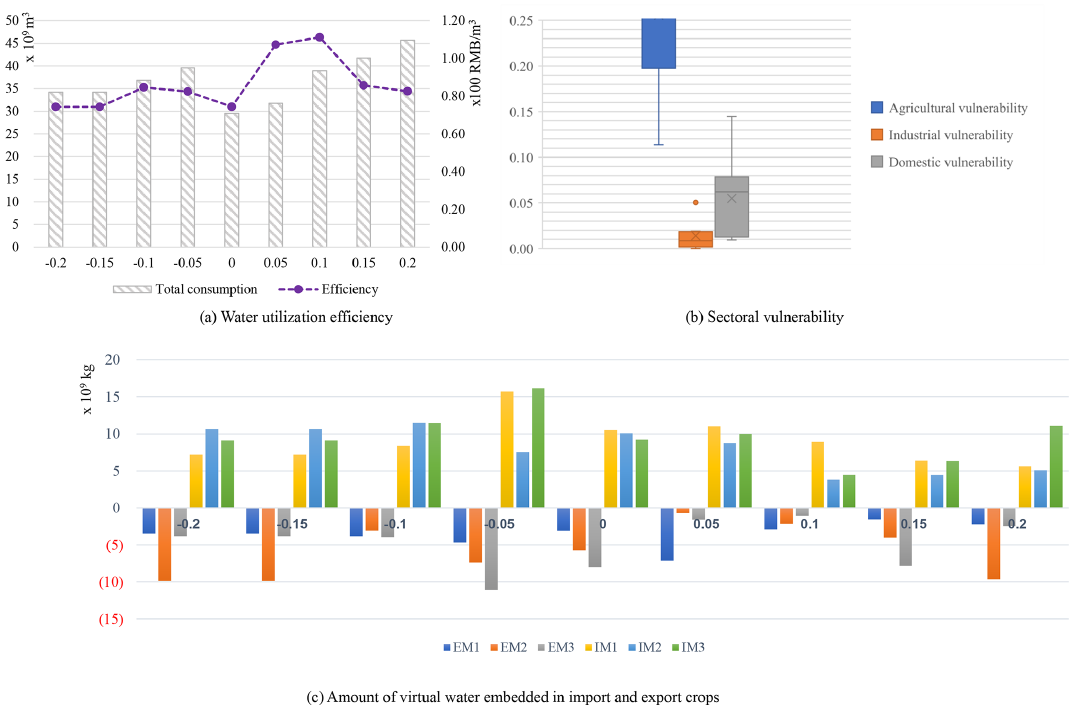
Figure 8. Sensitivity analysis of available water (in Fig. 8c virtual water embedded in export crops is shown below the x axis, while virtual water embedded in import crops is shown above the x